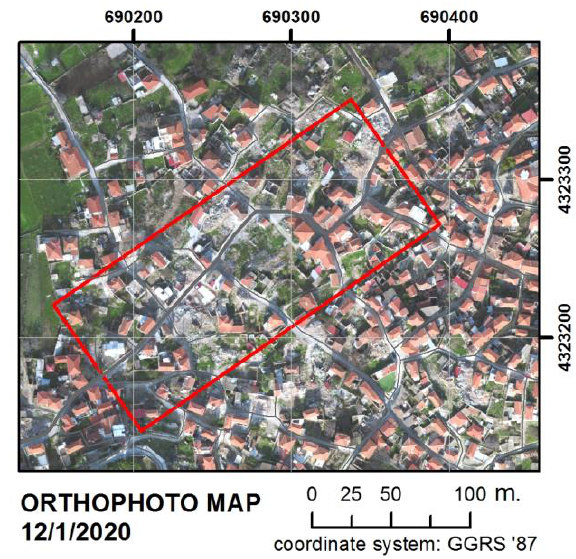
Figure 1. The study area is a part of the Vrisa settlement (0.022 km² area), that includes 80 buildings with all types of damages. The geological and geomorphological setting along with the spatial distribution of the damages on the buildings.